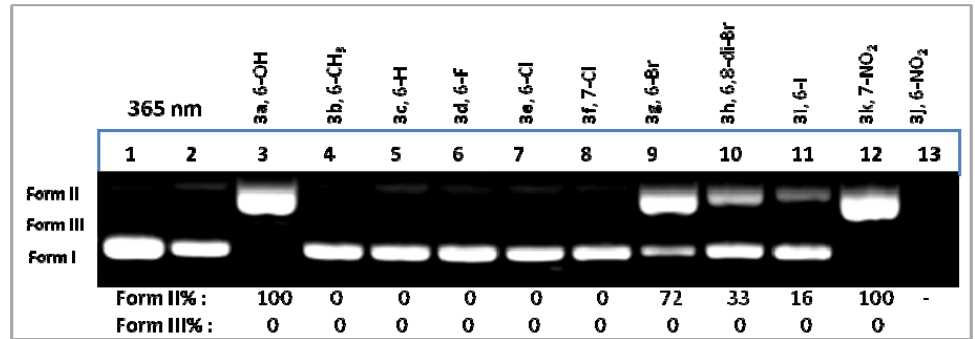
Figure 3. Efficiency on DNA photo-cleavage by QNZ derivatives 3a-3j and 3k at concentration of 500 μ M with UVA light (365nm). Gel electrophoresis data: Lane 1: DNA without UV irradiation; Lane 2: DNA with UV irradiation; Lanes 3–13: as indicated at the top of the agarose gel.